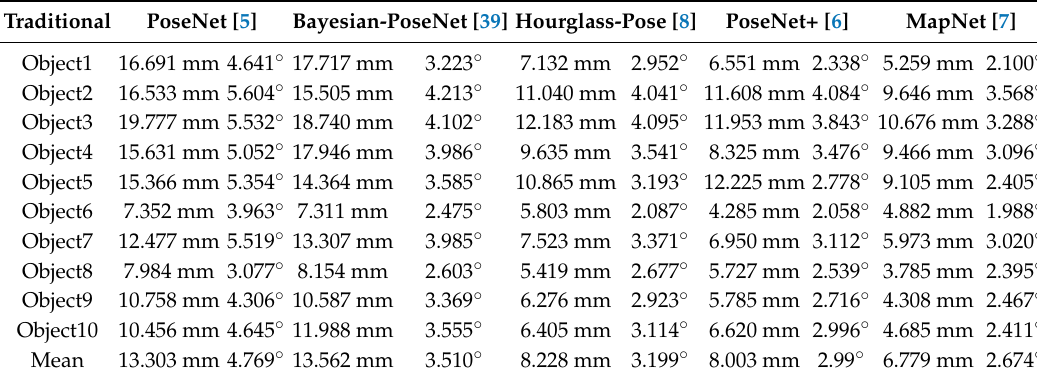
Table 6. Estimated camera location (mm) and orientation ( ◦ ) errors of different pose regression approaches using the post-processed Industrial10-WatchPose dataset.